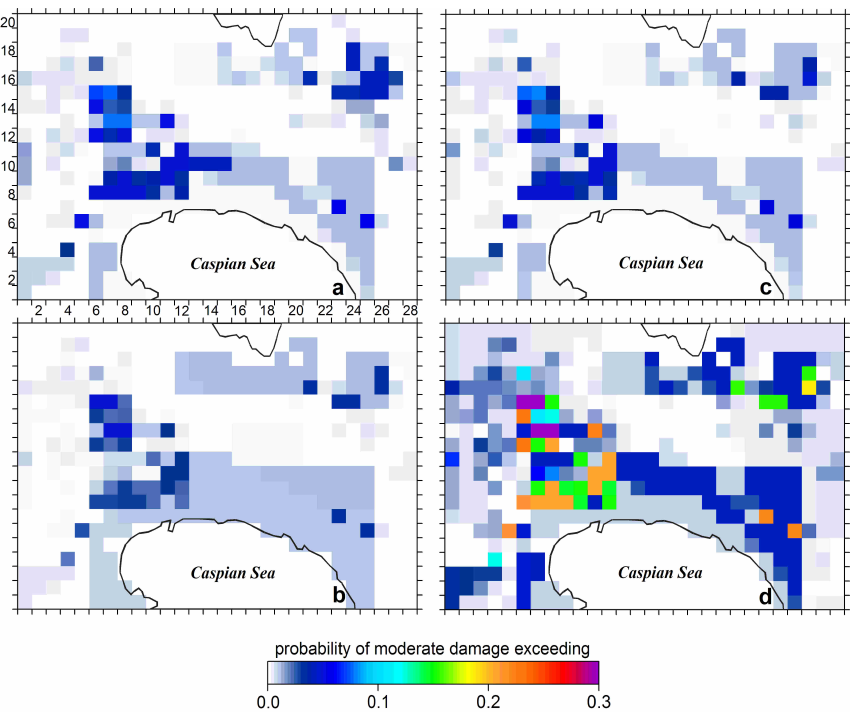
Fig. 7. Probability of exceeding moderate damage of the building structures for earthquake scenarios: ( a ) near event; ( b ) local event; ( c ) far event, and ( d ) extreme